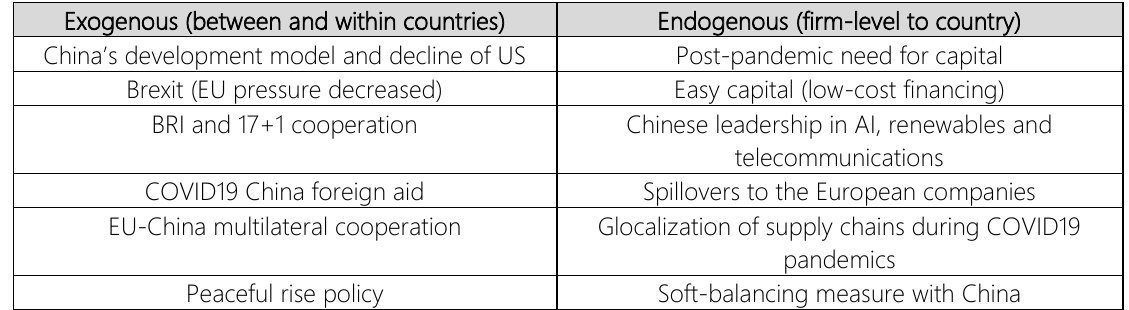
Table 2: Exogenous and endogenous opportunities which benefit and promote COFDI soft power (Source: Author‘s own